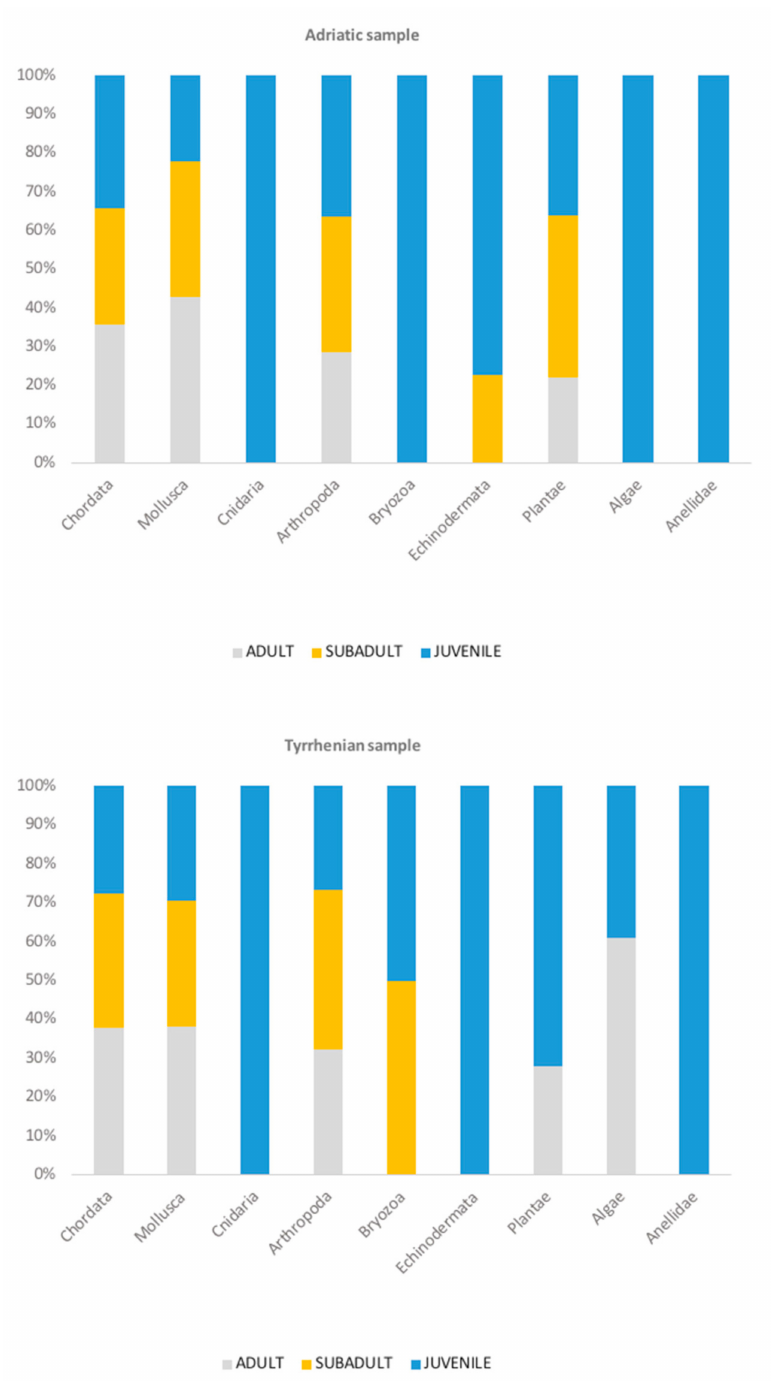
Figure 3. 100% stacked bar chart: contribution of each life stage group per phyla of prey